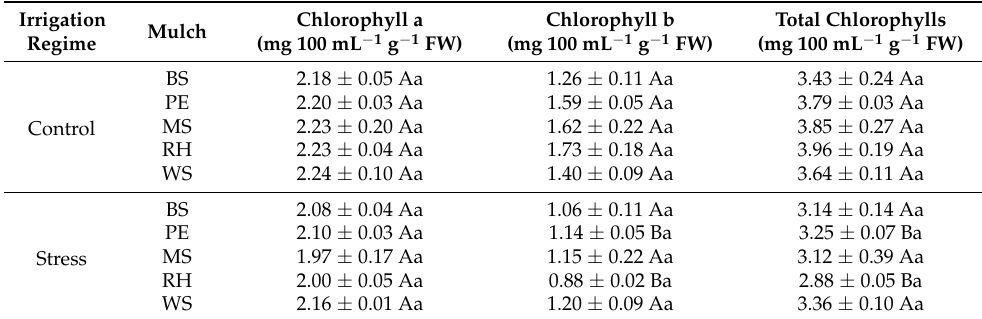
Table 2. Chlorophyll content in leaves of artichoke plants (cv. Symphony) cultivated under different mulching and irrigation